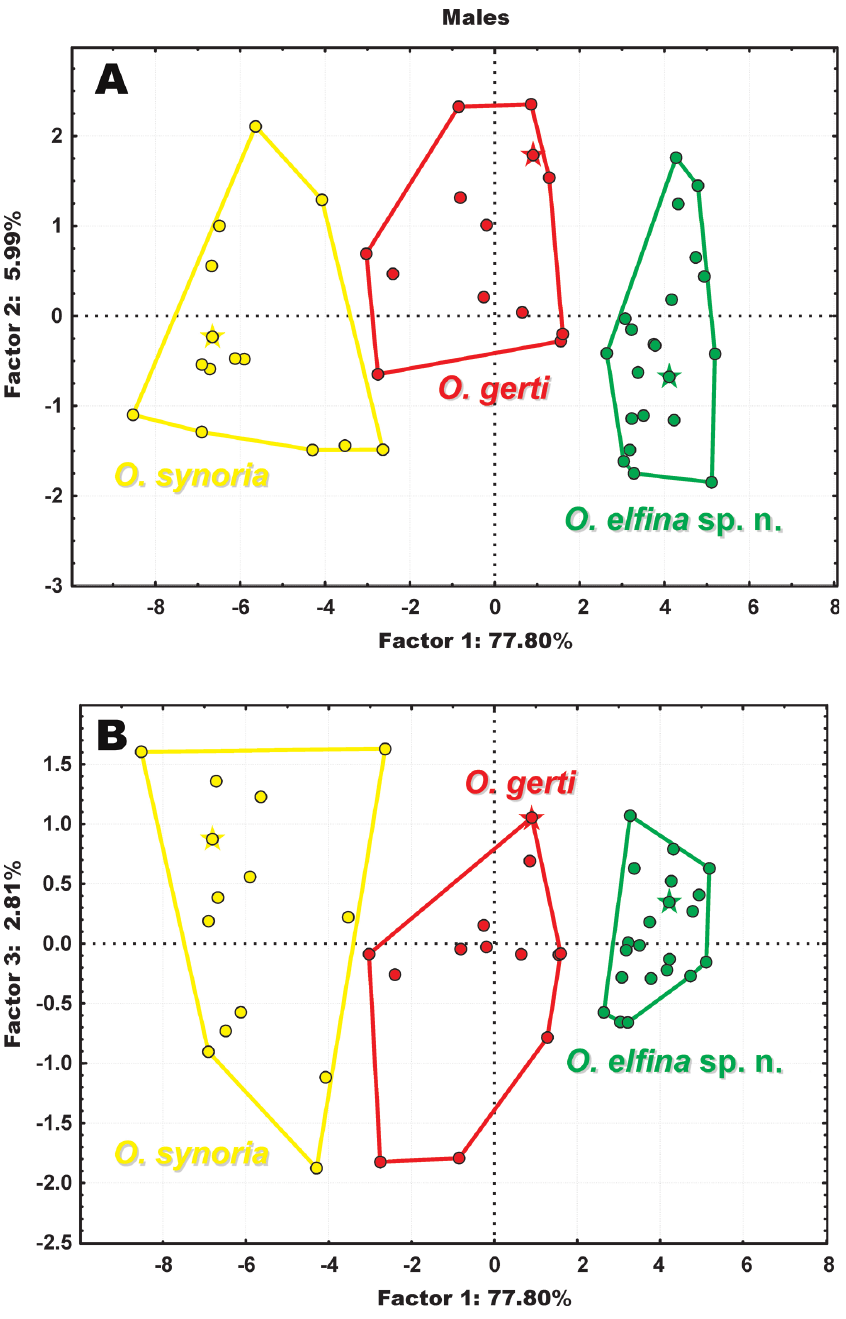
Figure 4. Two-dimensional plots of A the first two factors of PCA, and B the first and third factors of morphological characters for the Ophryophryne specimens examined. Data are given for males only. Star indicates the holotype specimen for each species. Circle color corresponds to those given in Fig.